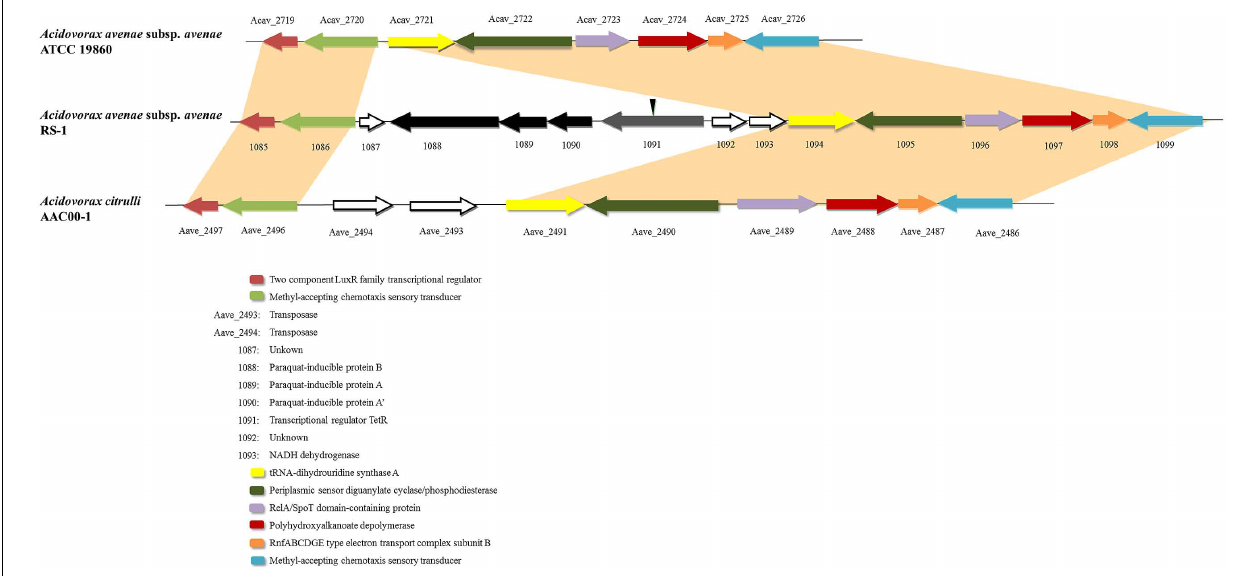
A. avenae subsp. avenae ATCC 19860 and A. citrulli AAC00-1. The single-headed arrows represent the position and orientation of the gene in genome. The deleted site of the tetR gene was shown by inverted